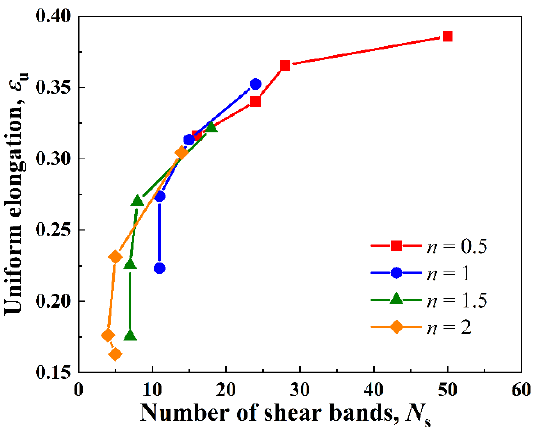
Figure 11. Relation between the number of shear bands N s and the uniform elongation ε u of the gradient Cu.